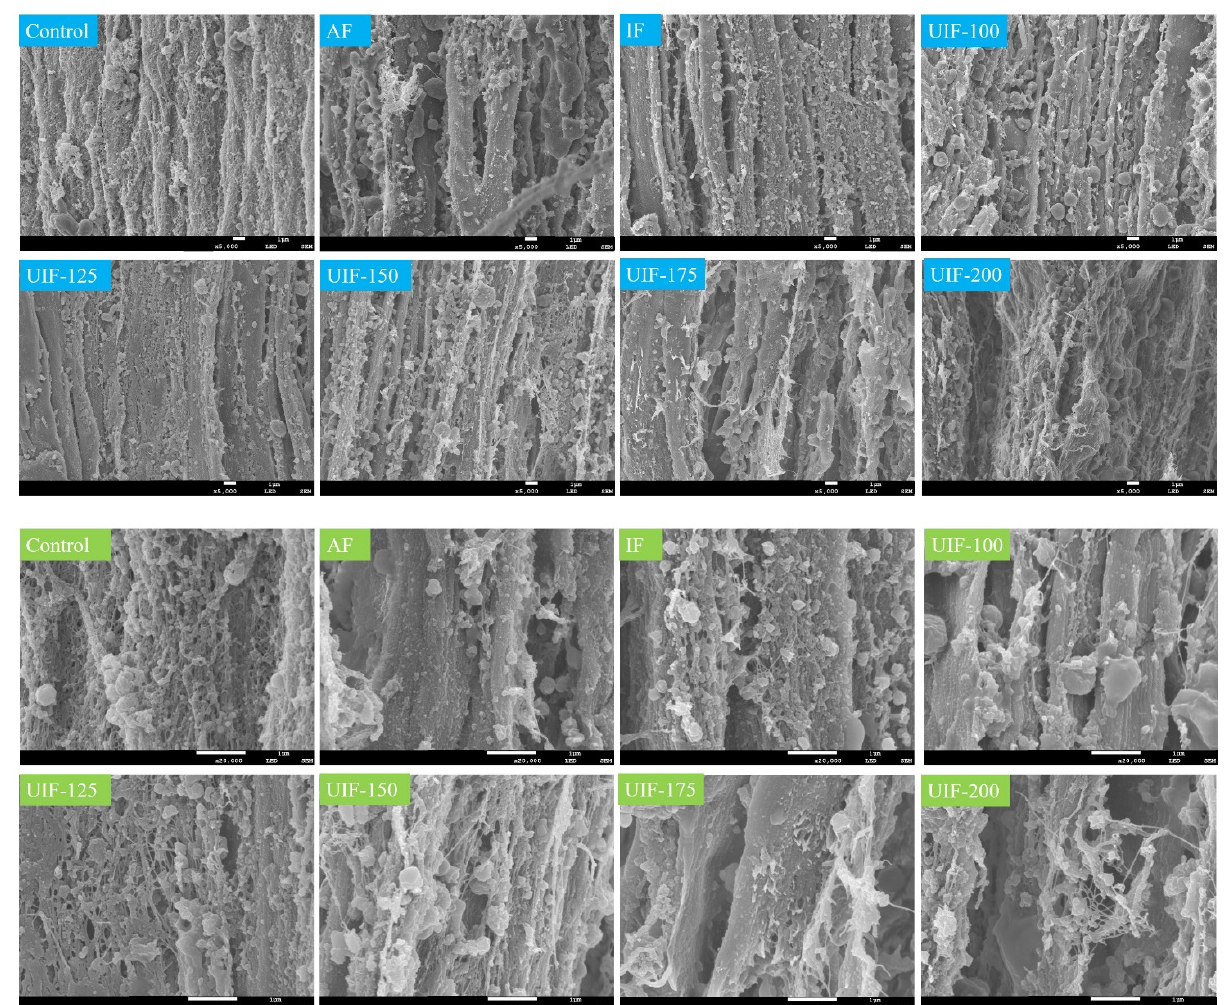
Figure 5. Scanning electron micrographs of the control AMS and 90-day frozen stored AMS with different treatments. AF, air freezing; IF, immersion freezing; UIF, ultrasound-assisted immersion freezing at different ultrasound powers (100, 125, 150, 175, and 200 W). The color of title is blue for magnification at 5000 × and green for magnification at 20,000 ×